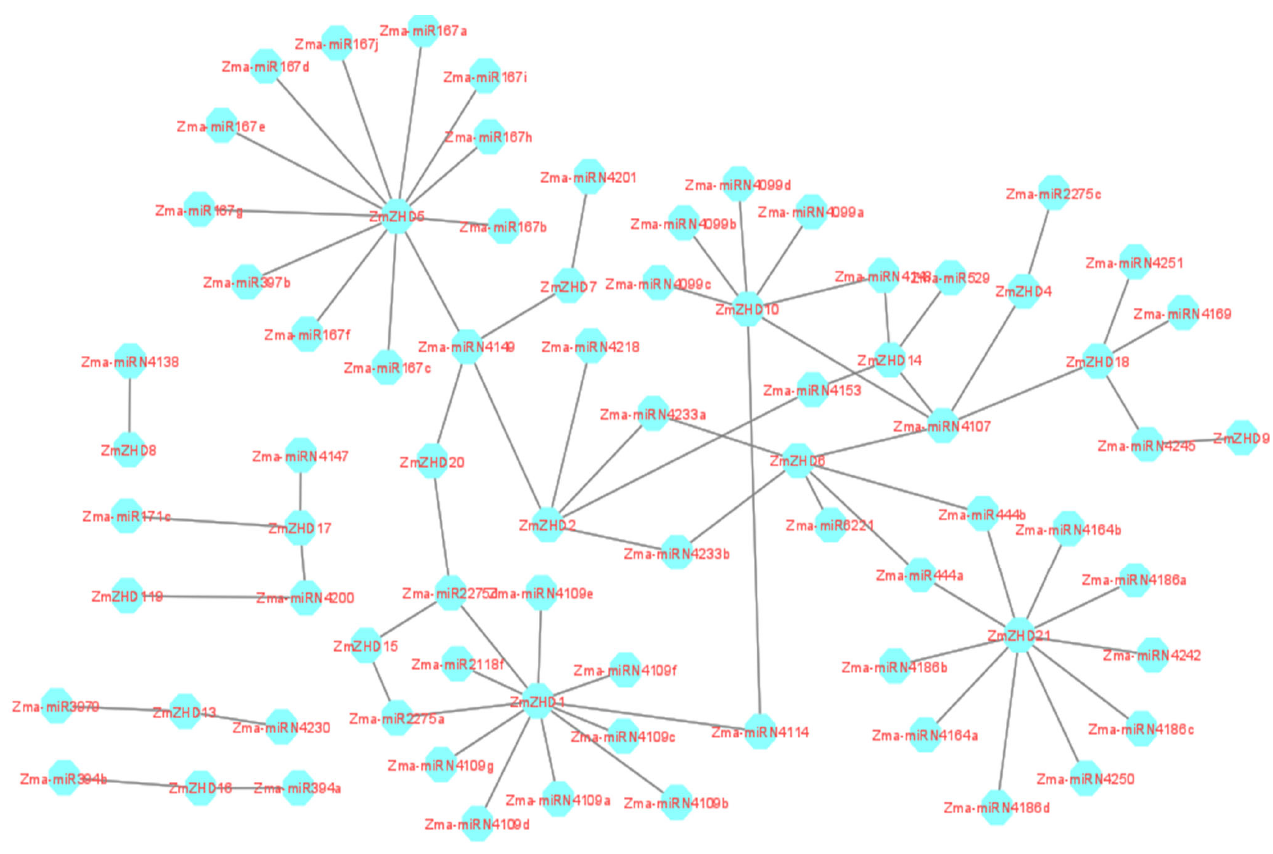
Figure 9. Picture of the regulatory network relationships between the putative miRNAs and their targeted maize ZHD genes.